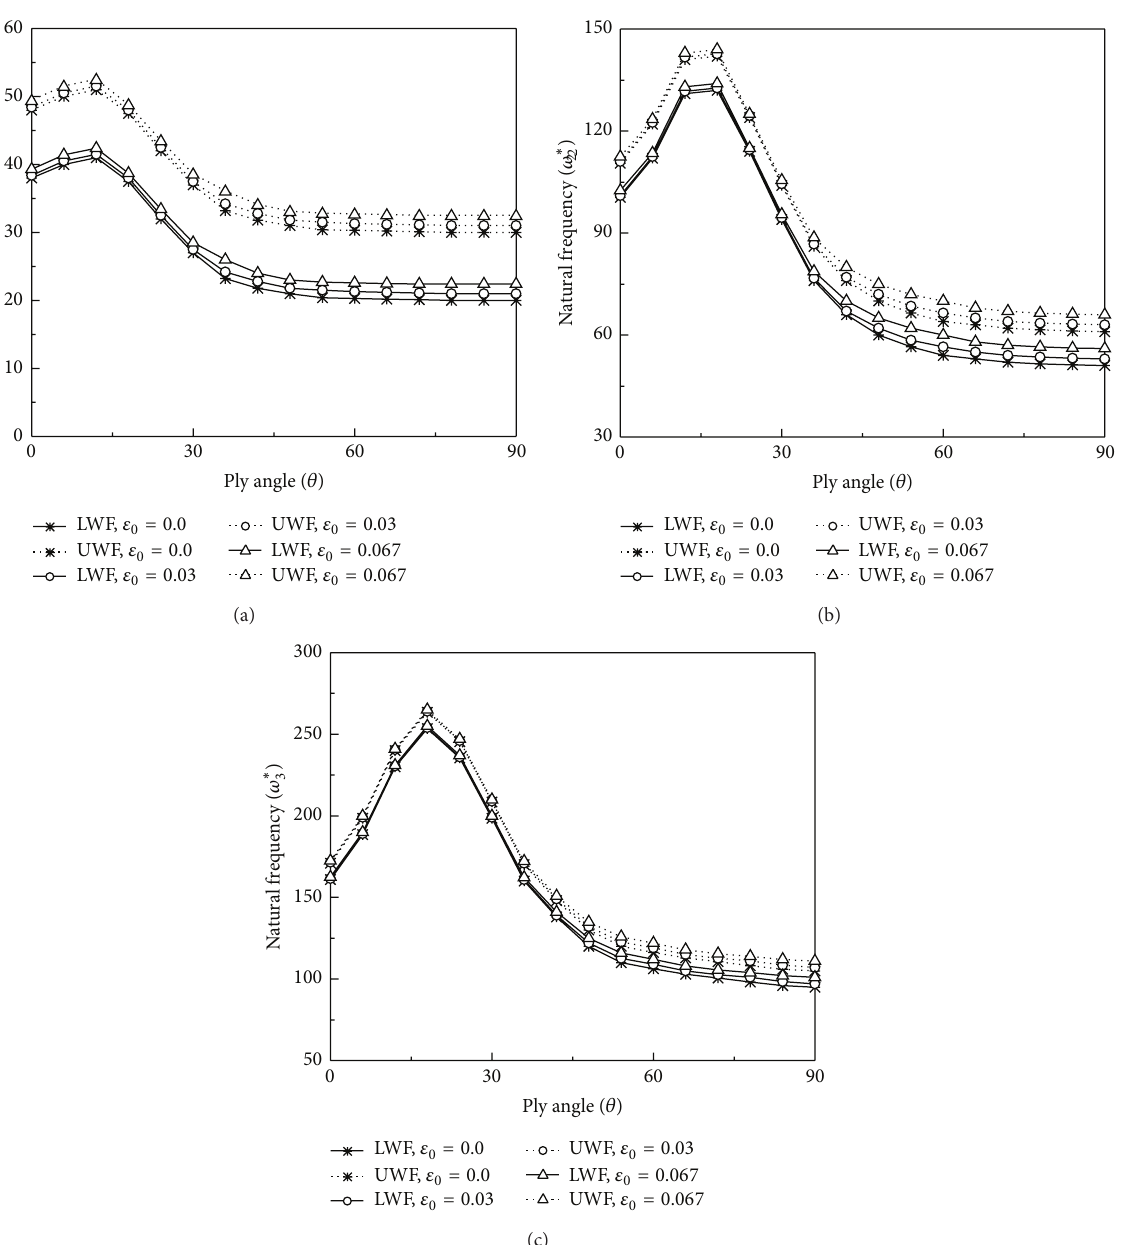
show that the effect of SMA wire fraction on the natural frequencies is substantial when the ply-angle is located near 90 ∘ . In addition, from Figure 5 it can be found that the trend of variation of natural frequencies with ply-angle is the same as that of the shaft without SMA actuation. Figure 5 also shows that as the SMA wire fraction increases, the natural frequencies